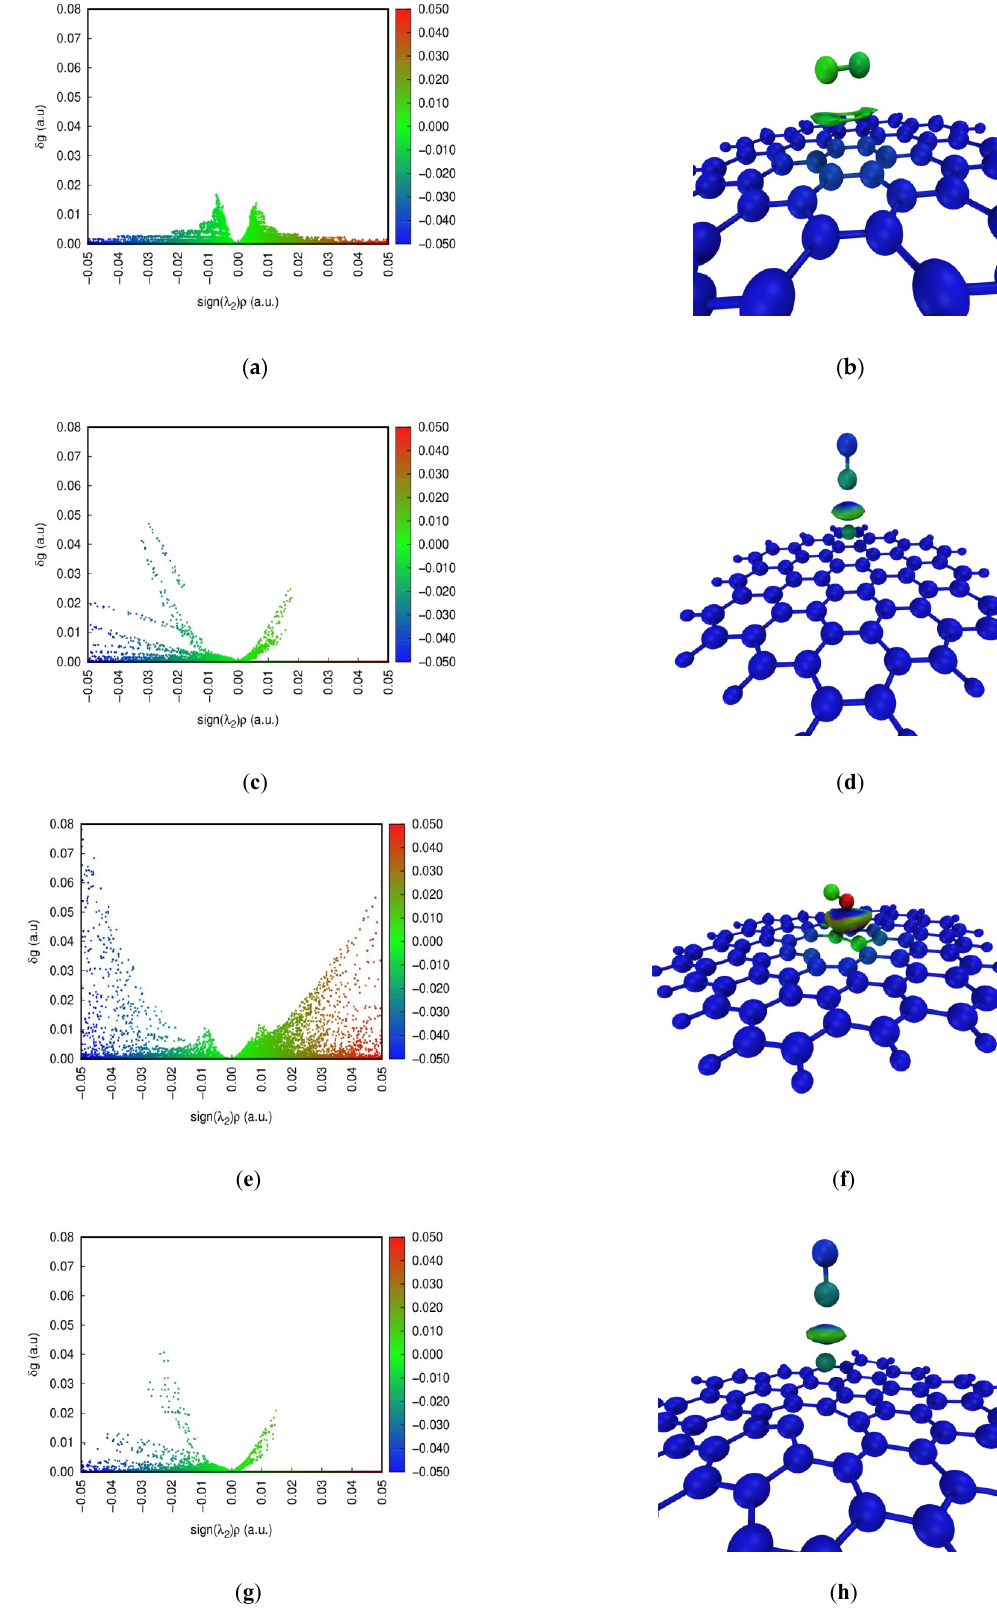
Figure 5. Color-scatter maps and isosurface maps of IGM analysis at ( a,b ) graphene-NO, ( c,d ) graphene-Na-NO, ( e,f ) gsv-NO, and ( g, h ) gsv-Na-NO.